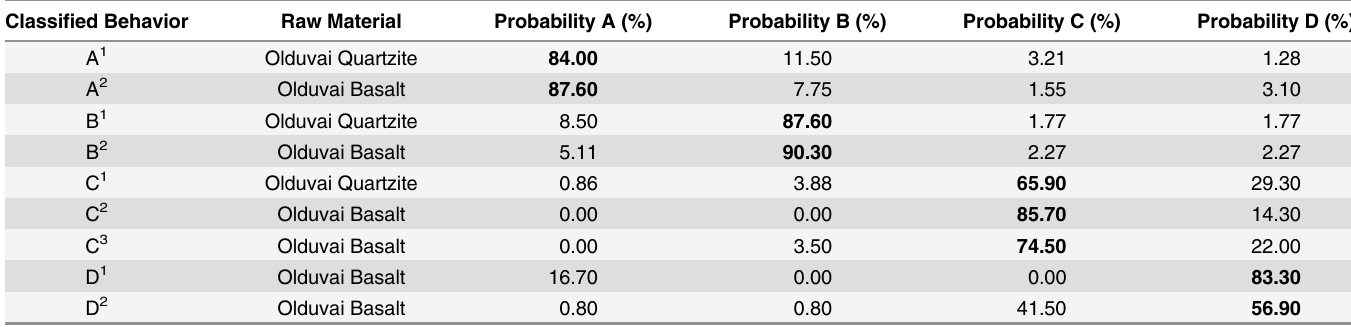
Table 2. Probability of correct classification for individual flakes (see Fig 4).